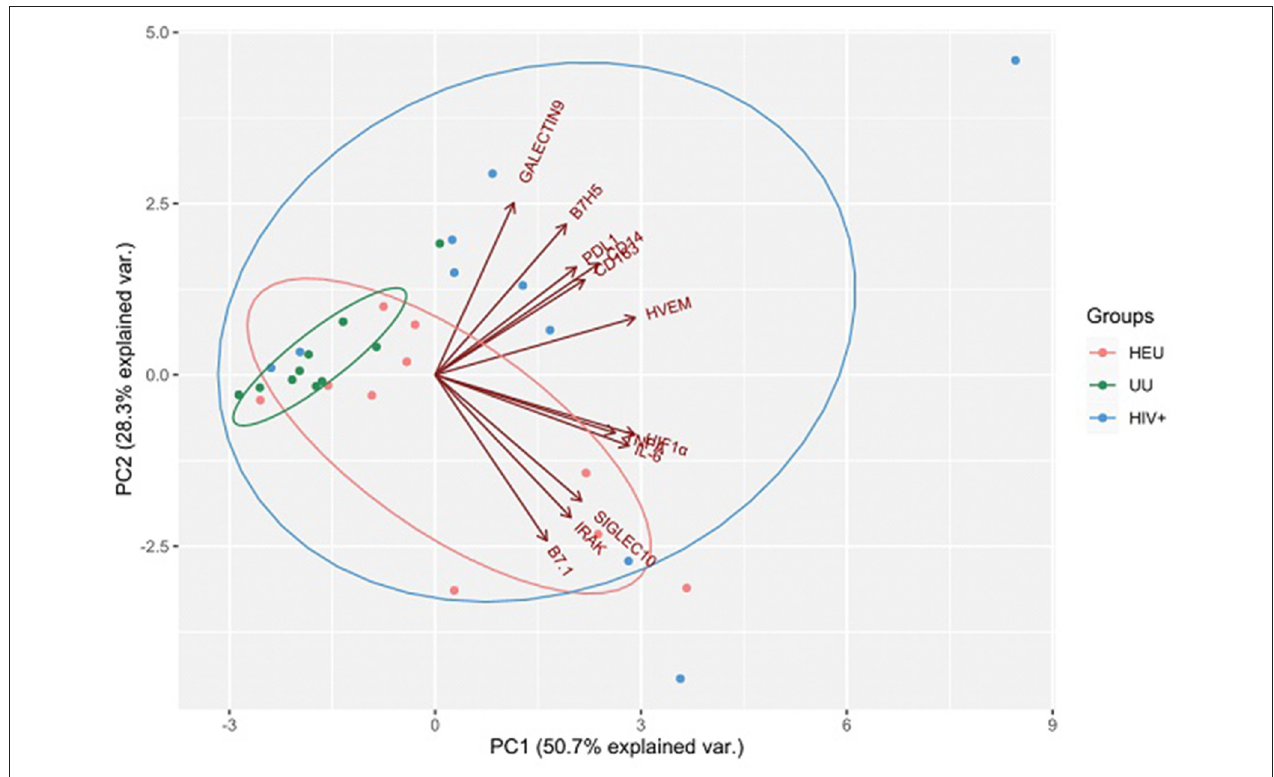
FIGURE 2 | Results are plotted according to the first two principal components accounting for 79% of the total variation (Component 1 = 50.7% and Component 2 = 28.3%). Each dot represents data from a single child sample: HIV-exposed but uninfected (HEU) in orange; HIV-infected (HIV + ) in blue; HIV-unexposed and uninfected (UU) in green. The clustering of samples is represented by their respective 95% confidence interval ellipse from centroid. Vectors of each immune marker are represented by red